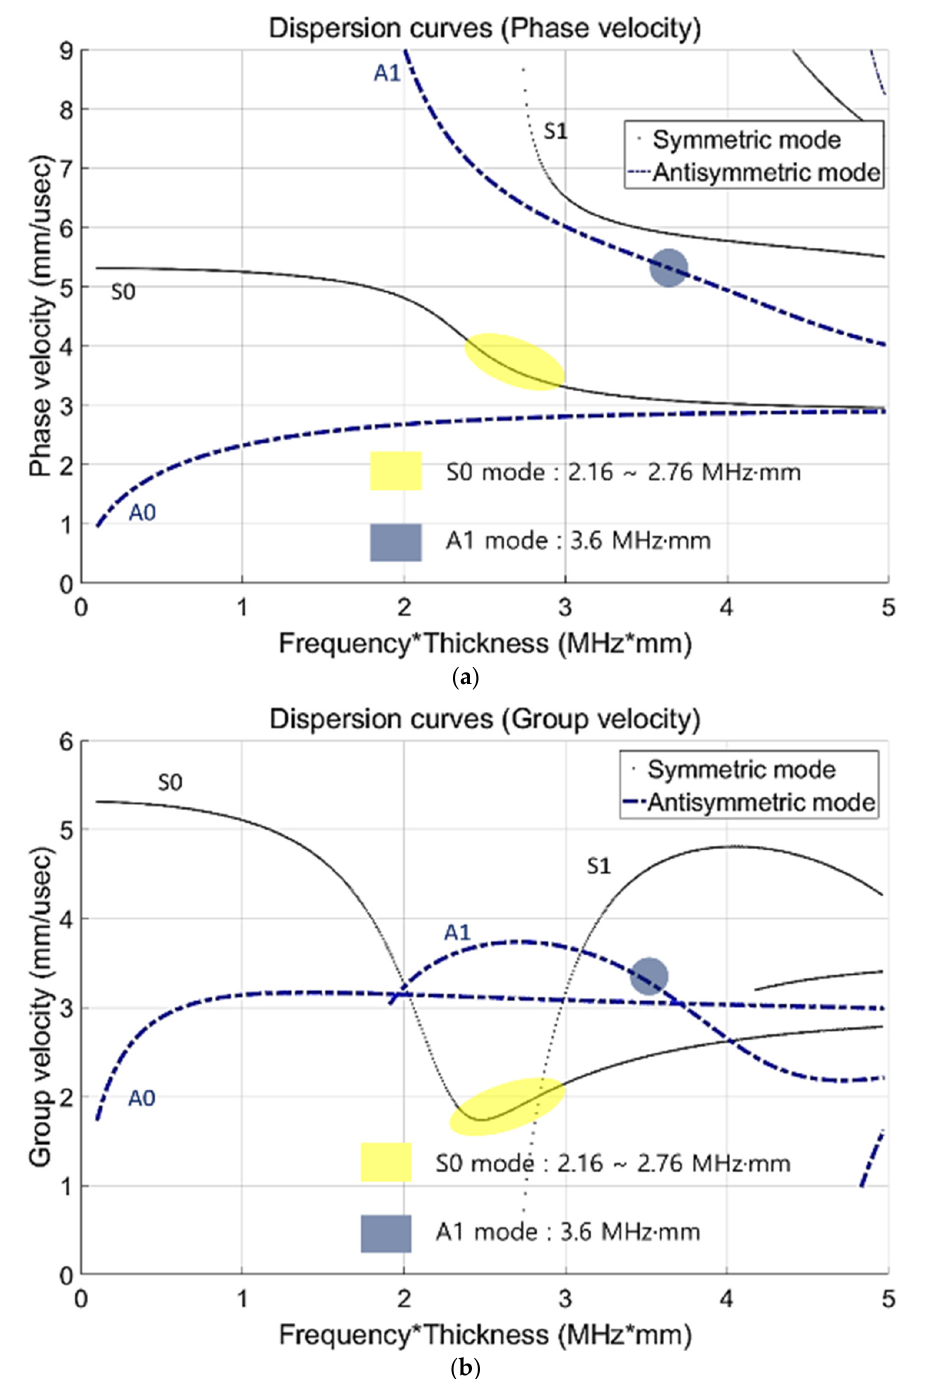
Figure 1. Lamb wave dispersion curves: ( a ) phase velocity and ( b ) group velocity. The Lamb wave mode needs to satisfy several conditions, including main mode dominance, sufficient propagation distance, and reliability of generation. Considering all terms of these conditions, with a preponderant reliability and dominance mode, S0 and A1 are the serviceable Lamb wave modes. In this study, the symmetric mode S0 (2.16 to 2.76 MHz · mm) was applied to visualize defects. In addition, for comparison of symmetric and antisymmetric transverse wave dominance modes, mode A1 (3.6 MHz · mm) was applied. Based on this comparison, the appropriate mode was chosen, considering the wave characteristics and visualization